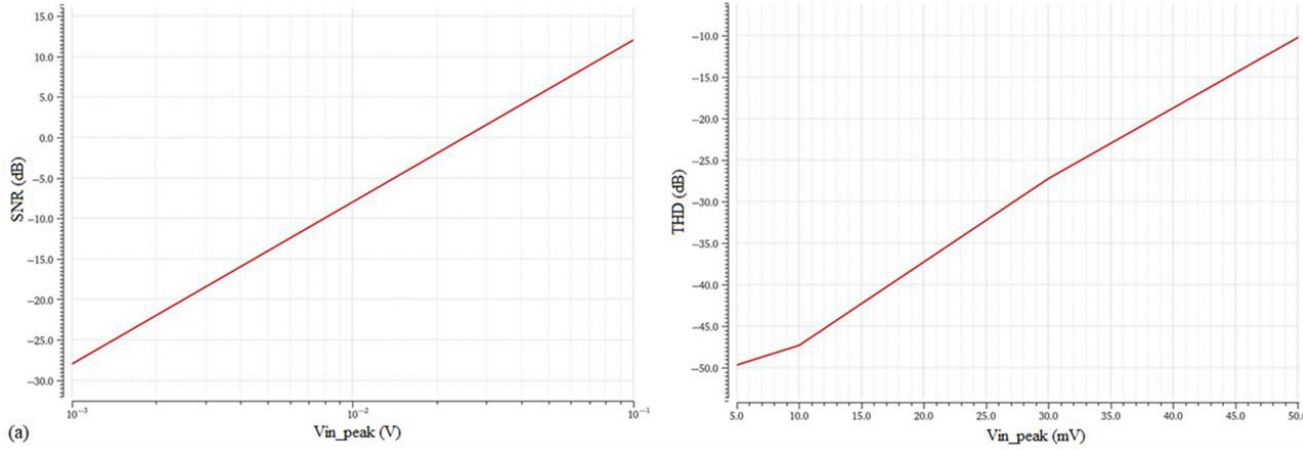
Figure 13. Signal-to-Noise Ratio (SNR) vs. V in_peak and Total Hamonic Distortion vs. V in_peak for the ( a ) R replacement, ( b ) L replacement, and ( c ) C replacement cascaded bandpass filter configuration. In Figure 14, the THD and SNR plots versus V in_peak for the leapfrog technique are depicted. From the diagrams in Figures 13 and 14, the values that appear on Table 8 are extracted.